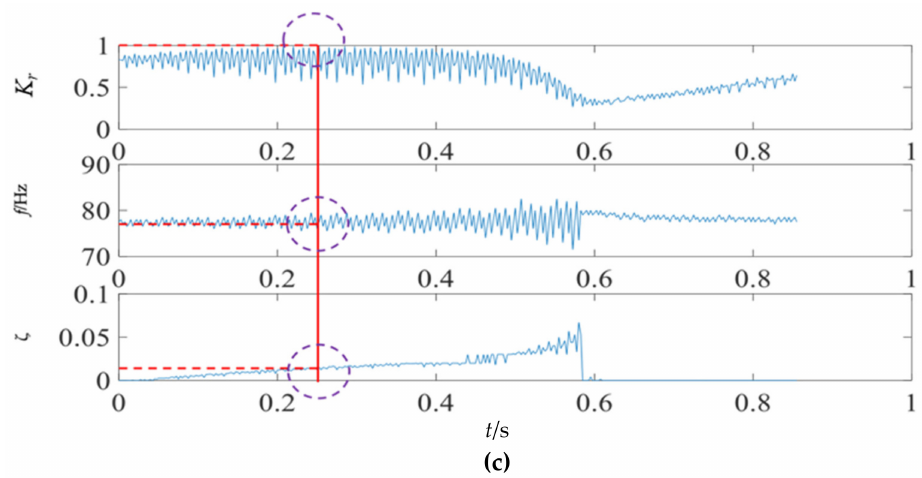
Figure 19. Third mode in the vibration response signal of the wooden utility pole labeled as 265173: ( a ) the vibration response of the third mode in the time domain, ( b ) the frequency spectrum of the third mode, ( c ) and the results of Laplace wavelet correlation filtering of the third mode.